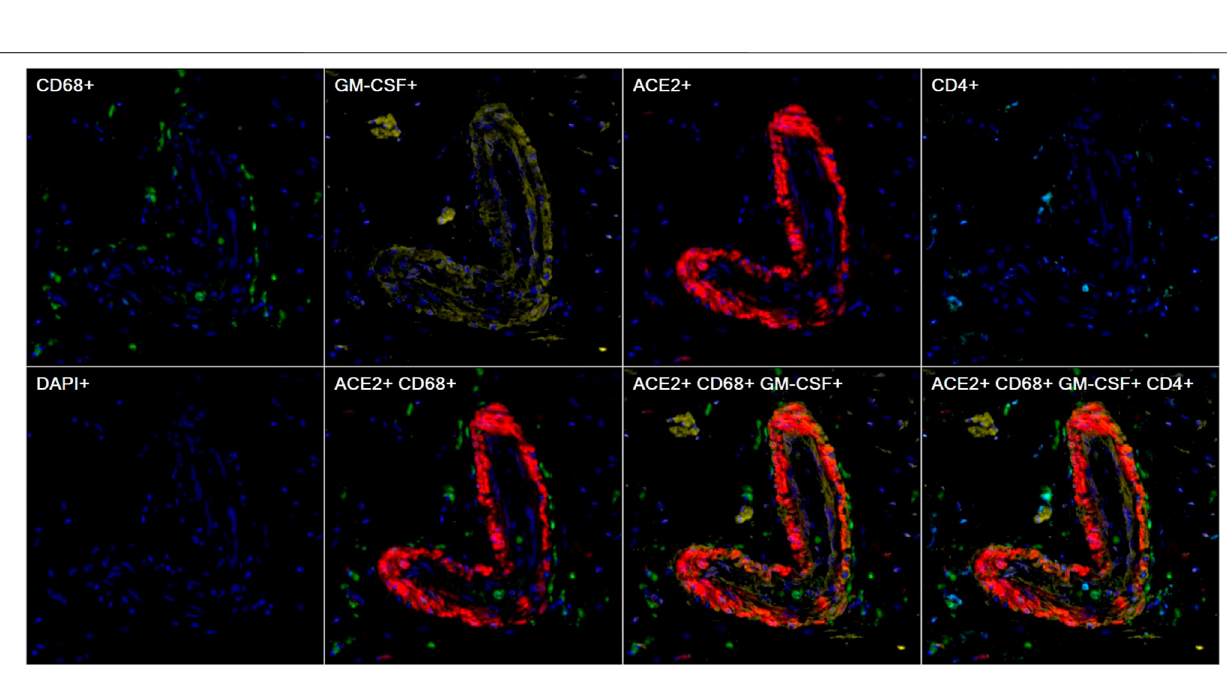
Frontiers in Molecular Biosciences |